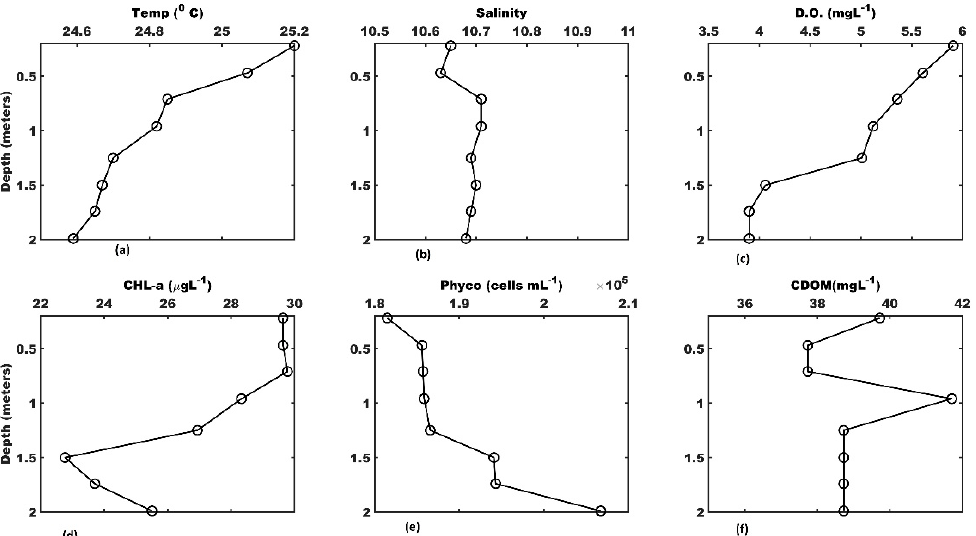
Figure 3. Vertical profiles in shallow triblet (<2 m) Church Creek. ( a ) weak thermocline ( b ) well- mixed with respect to salinity ( c ) Dissolved oxygen exhibits near saturation conditions at the surface, hypoxic at 1.5 m. ( d ) Chlorophyll-a high at the surface to 1 m. ( f ) CDOM with a maximum at 1 m.